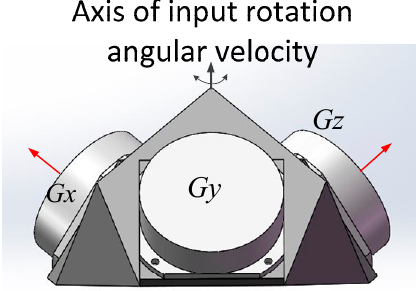
Figure 1. Structure of IMU based on RLG in rate-biased mode.